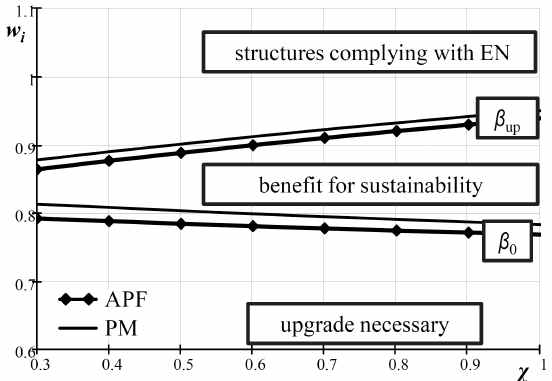
Figure 2. Variation of w i with χ (APF based on the actual values of sensitivity factors – α R = 0.2, α G = 0.2, and α Q =